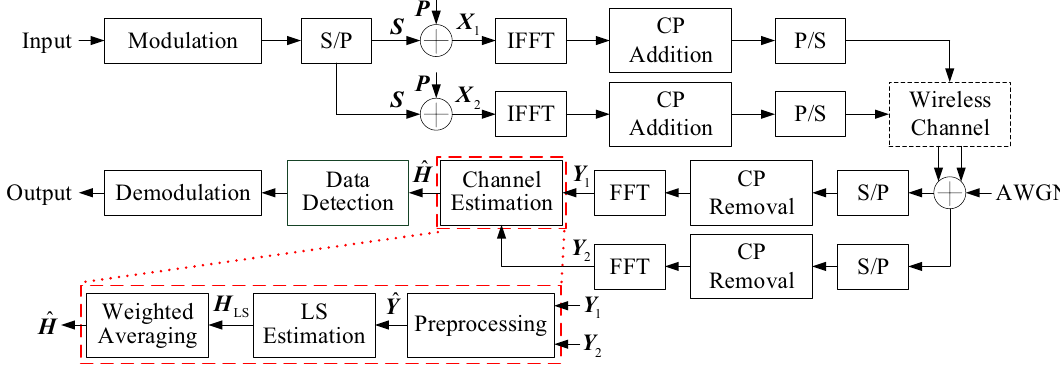
Figure 1. System architecture of the proposed SP-WA method.